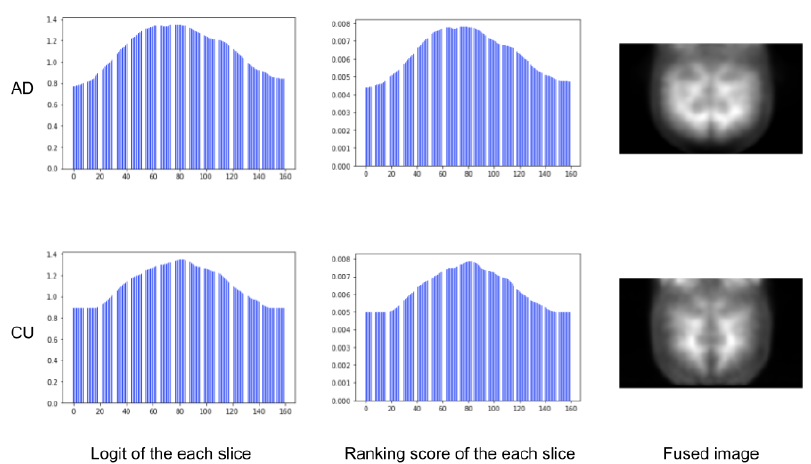
Figure 7. The visualization results of the PET image. The first column shows the digit of each slice. The second column shows the rank score of the slices after the softmax function. The last column shows the fused PET